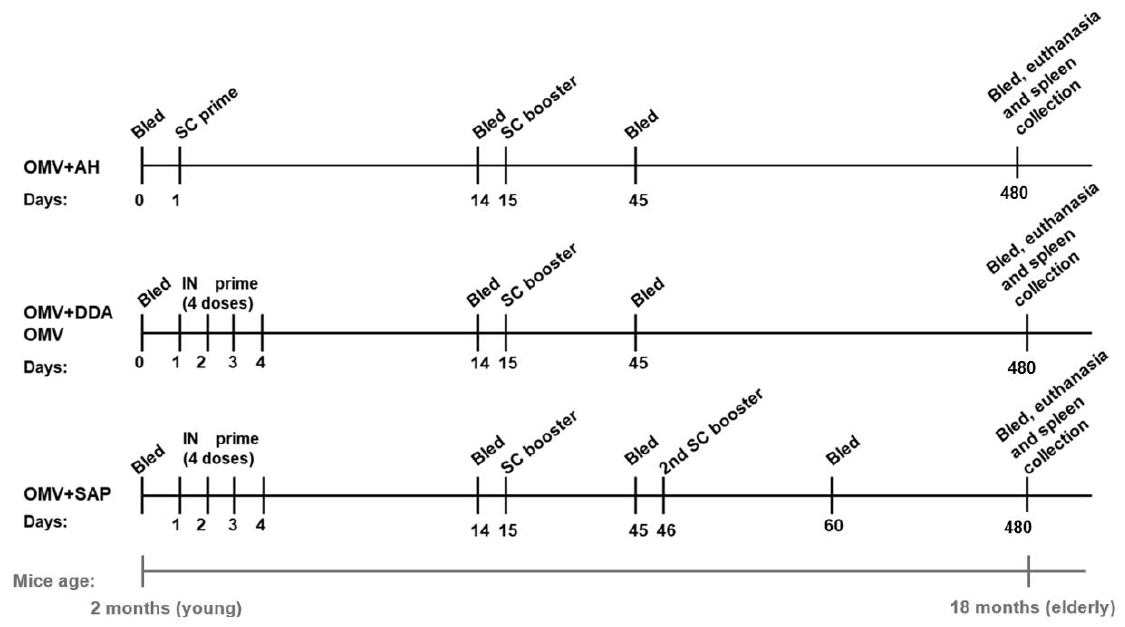
Figure 1. Immunization scheme and blood collections. AH: aluminium hydroxide; DDA: dimethyl- dioctadecylammonium bromide; IN: intranasal; OMV: outer membrane vesicles; Sap: Saponin; SC: subcutaneous.